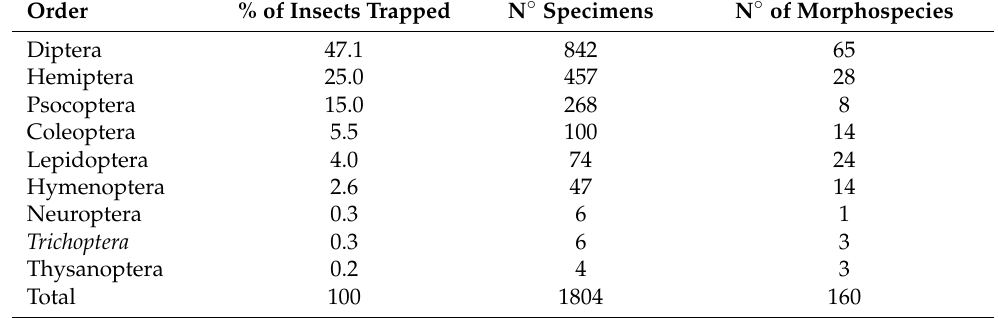
Table 2. Number of specimens and morphospecies of the orders trapped throughout the experiment.